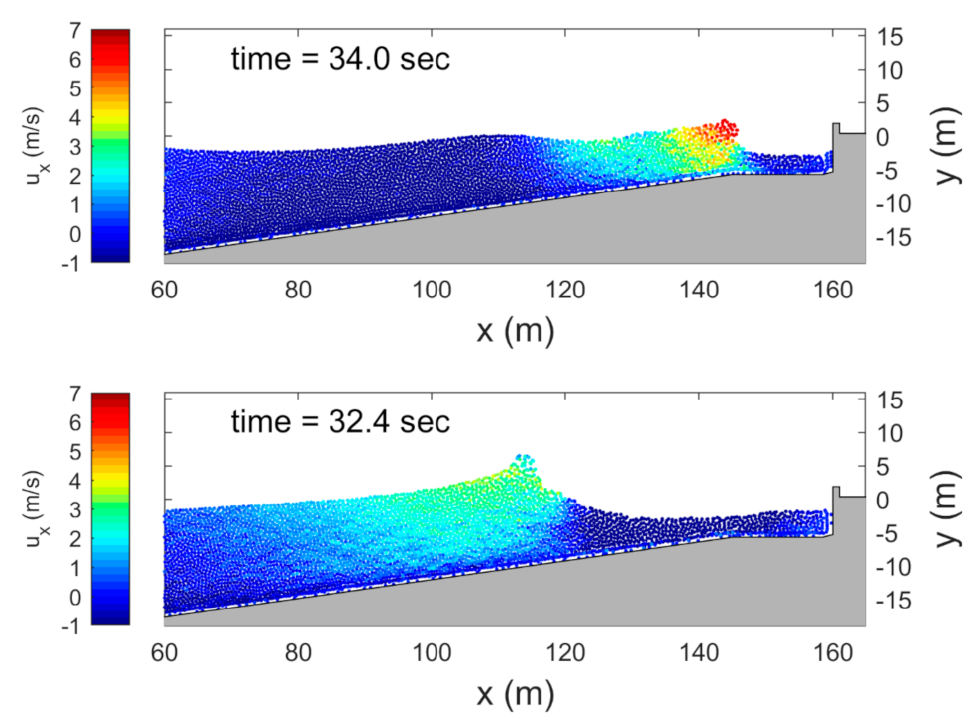
Figure 9. Simulation results of the interaction of incident and reflective waves for cases nA2 ( upper panel) and nA3 ( lower panel). They show different types of interactions at different